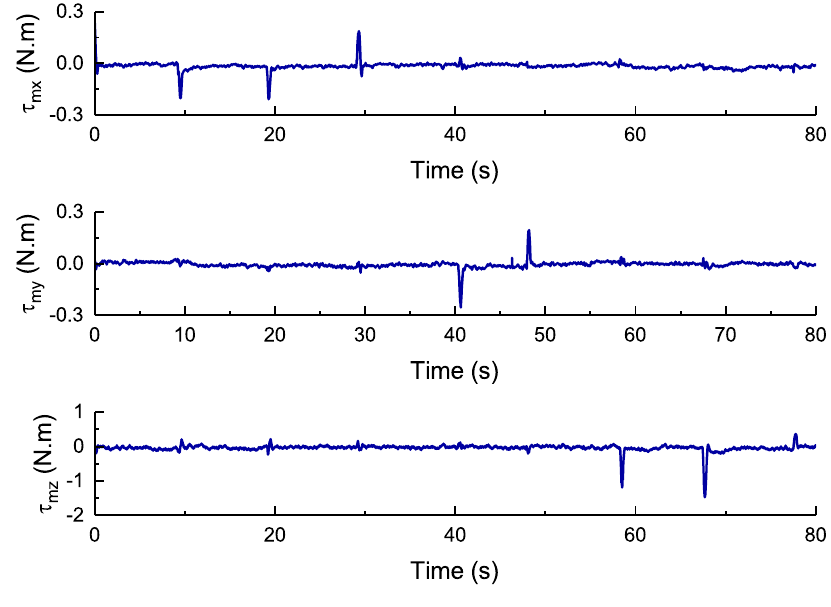
Figure 7. PI control